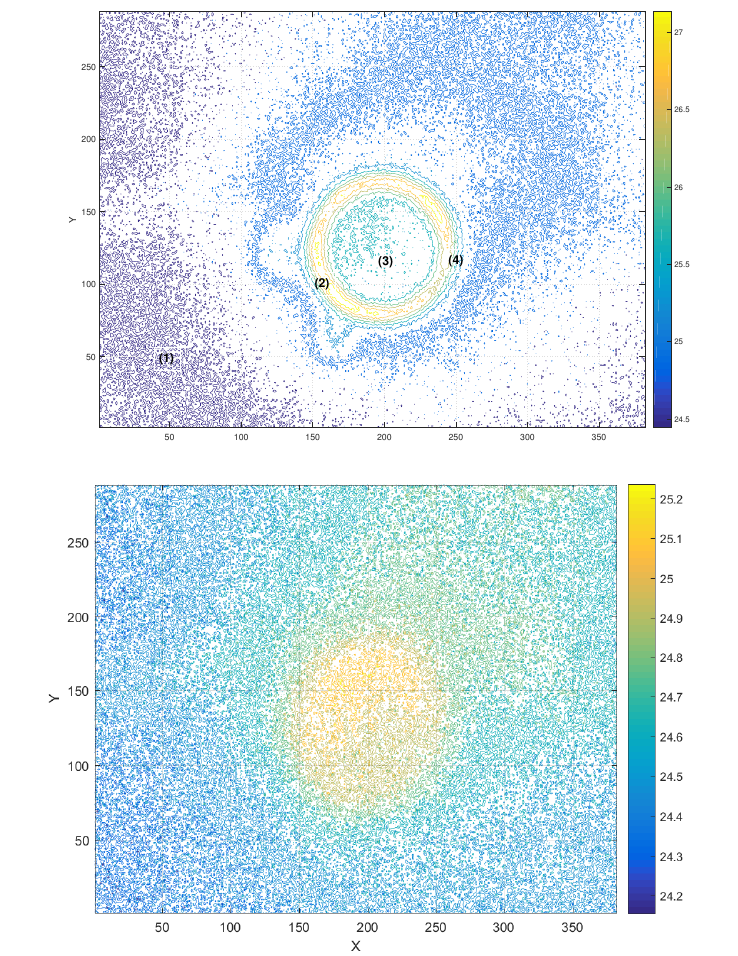
Figure 3. Contours of thermal traces for the initial ( top ) and final ( bottom ) time points. At the initial time point, contours are marked as the points used in experiments. Dimensions X and Y are in pixels.